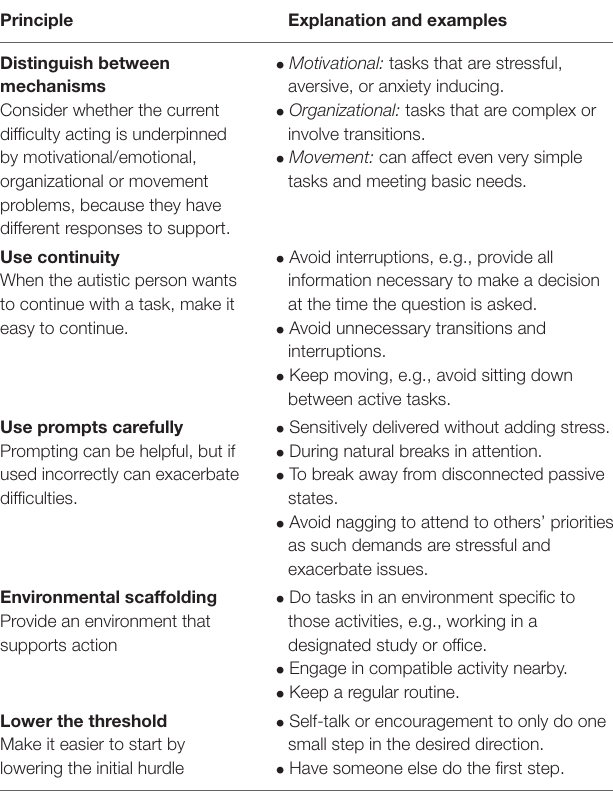
TABLE 4 | Principles for helping with autistic